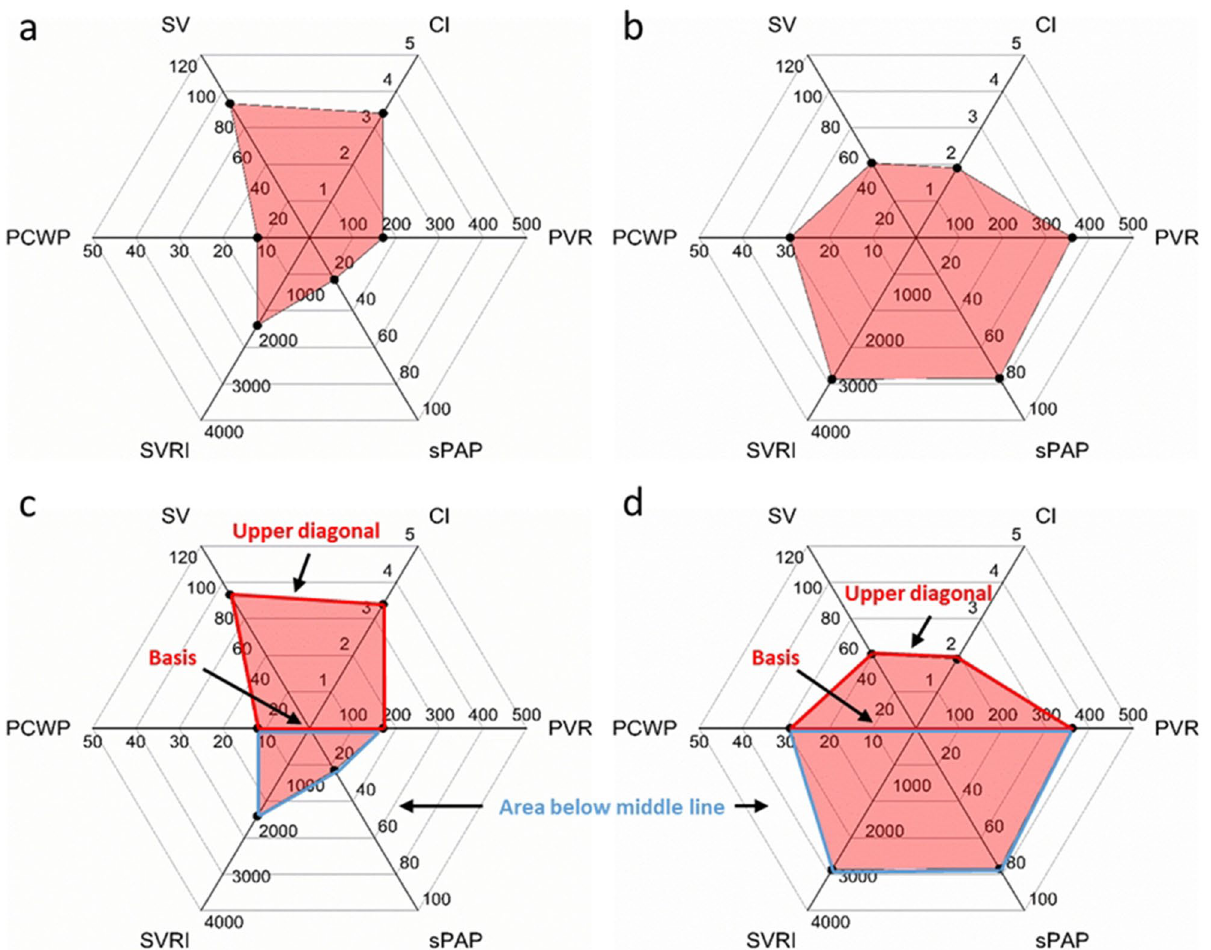
Figure 1. Hemodynamic profiling. Hemodynamic profiles. Panel a: healthy adult. Panel b: patient in cardiogenic shock. Hemodynamic profiles give an instant understanding of the hemodynamic situation and suggest treatment options. Panel c: same patient as in panel a. An upper diagonal longer that the length of the basis can indicate a compensated hemodynamic state. The blue borders define the area below the middle line. A small lower area in a compensated hemodynamic situation reflects normal status or optimal treatment. A small lower area in a state of decompensation can either indicate optimal treatment or the need for more vasopressor support, depending on the underlying cardiac pathology. Panel d: the base is longer than the upper diagonal, indicating cardiac stress or cardiac decompensation. The large filled area below the middle line indicates treatment options such as lowering PVR and/or sPAP. Effective treatment should increase the cardiac index and lengthen the upper diagonal in relation to the basis and reduce the filled area below the middle line. CI: cardiac index [L·min -1 ·m -2 ]; SV: stroke volume [mL]; PCWP: pulmonary capillary wedge pressure [mmHg]; SVRI: systemic vascular resistance index [dyn·s·cm −5 ·m −2 ]; sPAP: systolic pulmonary artery pressure [mmHg]; PVR: pulmonary vascular resistance [dyn·s·cm −5